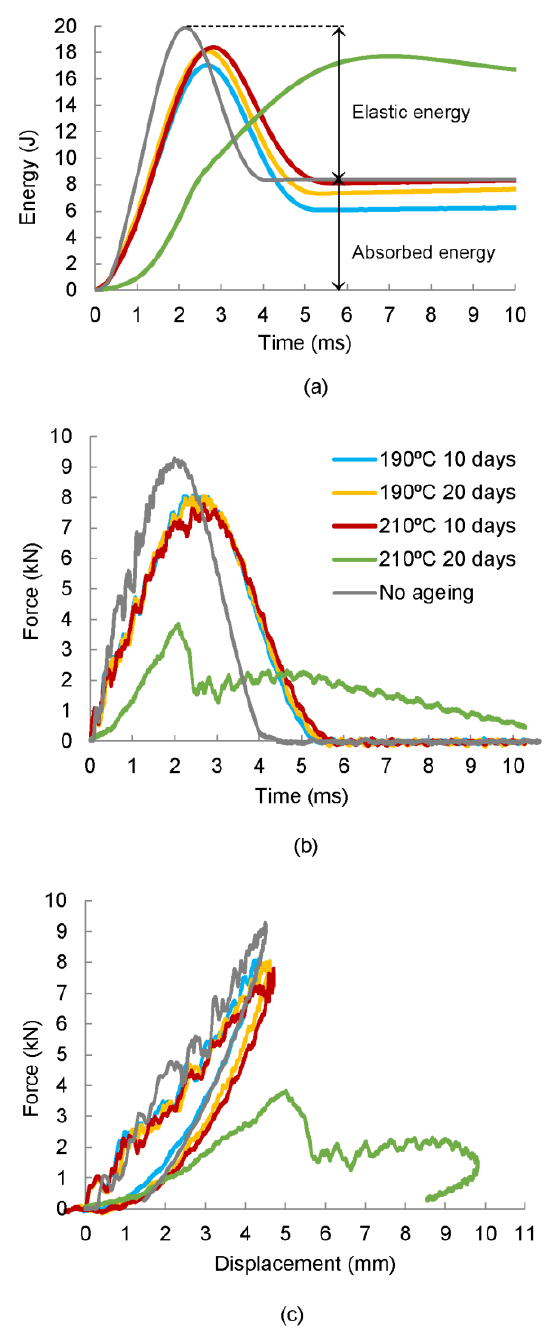
Figure 6. ( a ) Average energy and ( b ) force histories and ( c ) force–displacement curves of non-aged [0/90/±45] 2s quasi-isotropic composite laminates with different ageing processes.